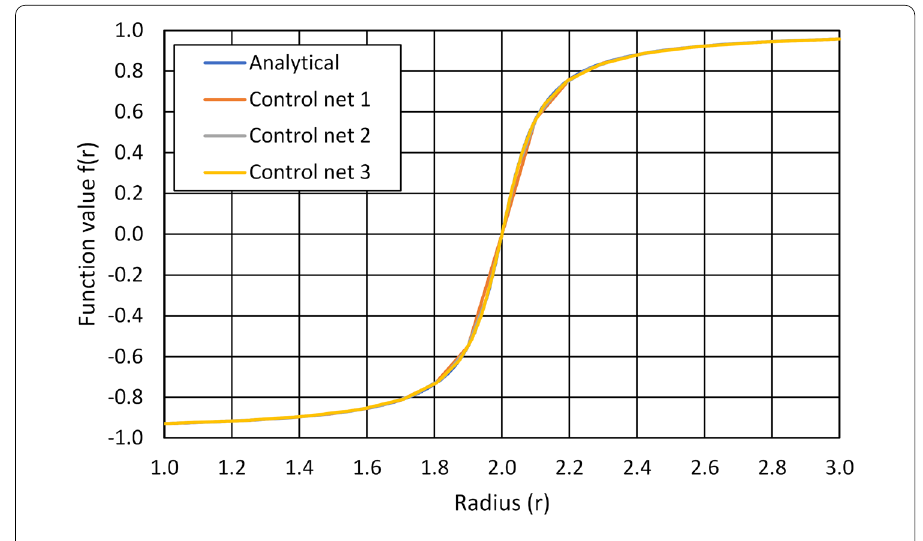
Fig. 21 Solution f ( r ), with r the radius